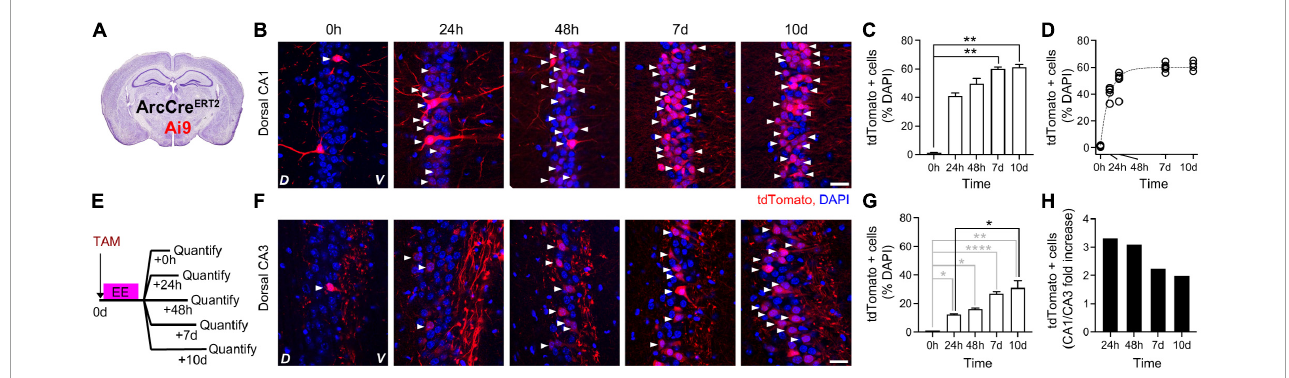
FIGURE3 Kinetics of ArcCre ERT2 -dependent expression of tdTomato in dorsal hippocampus upon exposure to an Enriched Environment. (A) Schematic description of ArcCre ERT2 —Ai9 double transgenic animals. (B) Confocal pictures, single Z-planes, of dCA1 at different time points after induction of tdTomato expression. Red, tdTomato; blue, DAPI. White triangles indicate tdTomato-positive cells. D, Dorsal, V, Ventral. Scale bar = 20 µ m. Modified from Castello-Waldow et al. (2020). (C) Percentage of tdTomato-expressing over DAPI-positive cells in dCA1 at different time points after exposure to EE. The levels of tdTomato at 7 and 10 days were significantly higher than baseline (0 h) ( p 7d - 0h = 0.0012 and p 10d - 0h = 0.0007, all other p > 0.14, all n = 5; Kruskal–Wallis test after Dunn’s correction for multiple comparisons). Modified from Castello-Waldow et al. (2020). (D) Single exponential fit to the time course of ArcCreER T2 -dependent tdTomato expression shown in C. Plateau = 60%, R 2 = 0.96. Circles represent single datapoints (percentage of tdTomato-expressing over DAPI-positive cells in dCA1 at different time points after exposure to EE per mouse), dashed line is the best fit curve. (E) Schematic description of the experimental design to determine the expression kinetics of tdTomato in dCA3 under the control of endogenous Arc upon exposure to EE. (F) Confocal pictures, single Z-planes, of dCA3 at different time points after induction of tdTomato expression. Red, tdTomato; blue, DAPI. White triangles indicate tdTomato-positive cells. D, Dorsal, V, Ventral. Scale bar = 20 µ m. (G) Percentage of tdTomato-expressing over DAPI-positive cells in dCA1 at different time points after exposure to EE. The levels of tdTomato were significantly higher than baseline (0 h) on all days ( p 24 - 0h = 0.03, p 48h - 0h = 0.03, p 7d - 0h < 0.0001, p 10d - 0h = 0.0091; n 0h = 1, n 24h = 2, n 48h = 2, n 7d = 5, n 10d = 4; One-sample t -test). Comparison to the 24 h timepoint retrieved a trend at time point 7 days and a significant increase at time point 10 ( p 48h - 24h = 0.93, p 7d - 24h = 0.0719, p 10d - 24h = 0.025; n 24h = 2, n 48h = 2, n 7d = 5, n 10d = 4; One-way ANOVA with Sidak correction for multiple comparisons). (H) Ratio of dCA1 over dCA3 tdTomato expression levels at different time points after induction. * p < 0.05, ** p < 0.01, **** p <